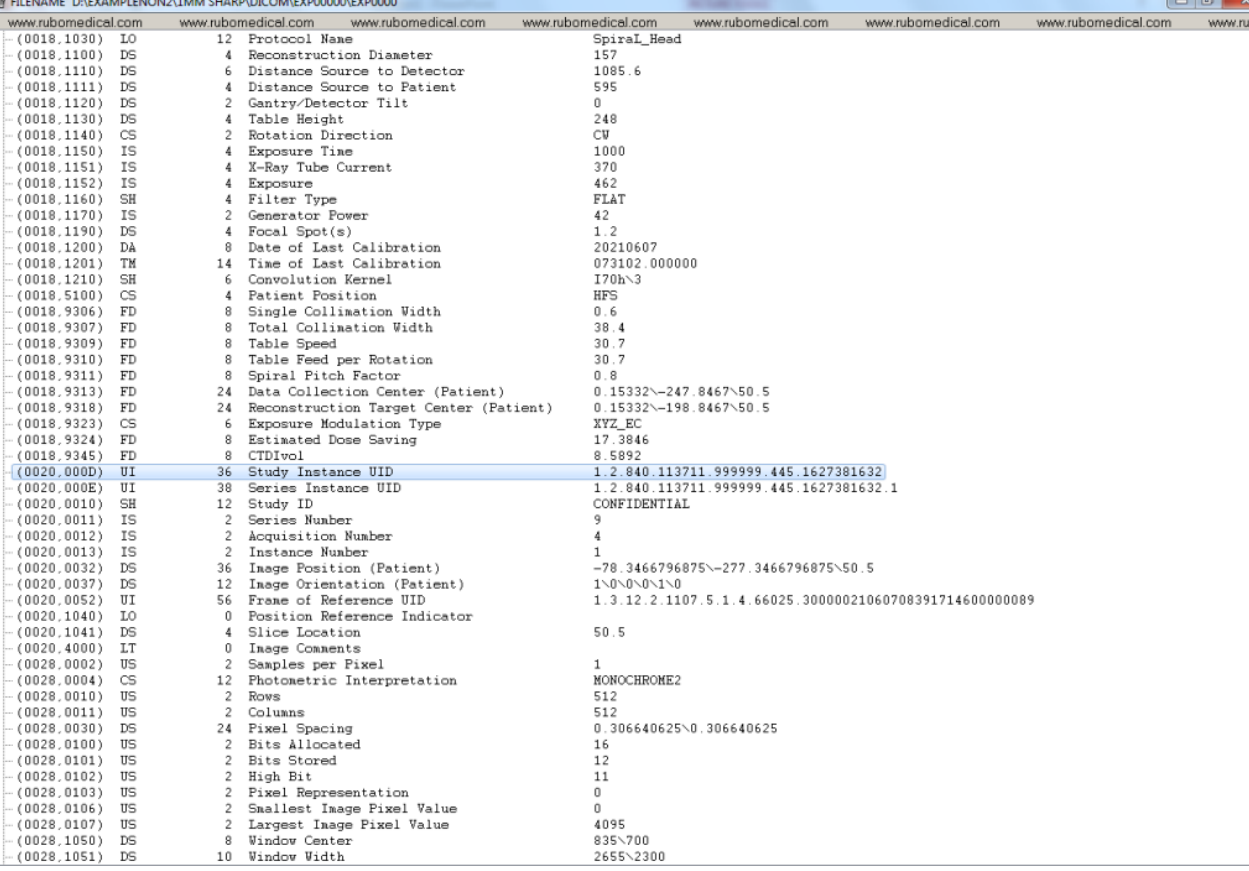
Figure A6. De-identified DICOM header data (part 2).